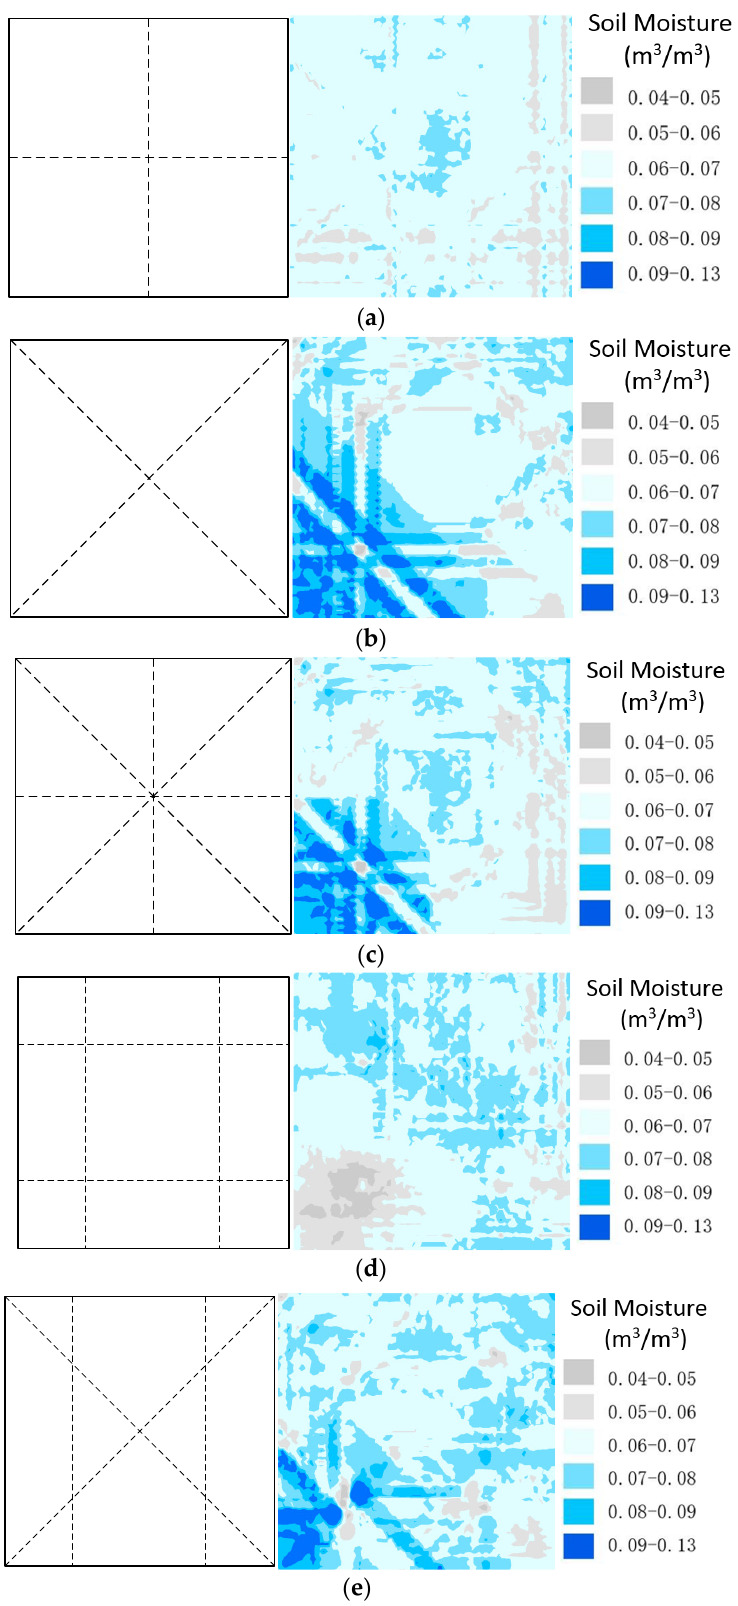
Figure 7. Spatial distributions of soil moisture in Plot D by two survey lines designed in Shape Ⅰ ( a ) and Shape Ⅱ ( b ), and by four survey lines in Shape Ⅲ ( c ), Shape Ⅳ ( d ) and Shape Ⅴ ( e ), respectively. Table 1. Spatial distribution accuracy of soil moisture measurements in different survey line shapes for Plot A-D.